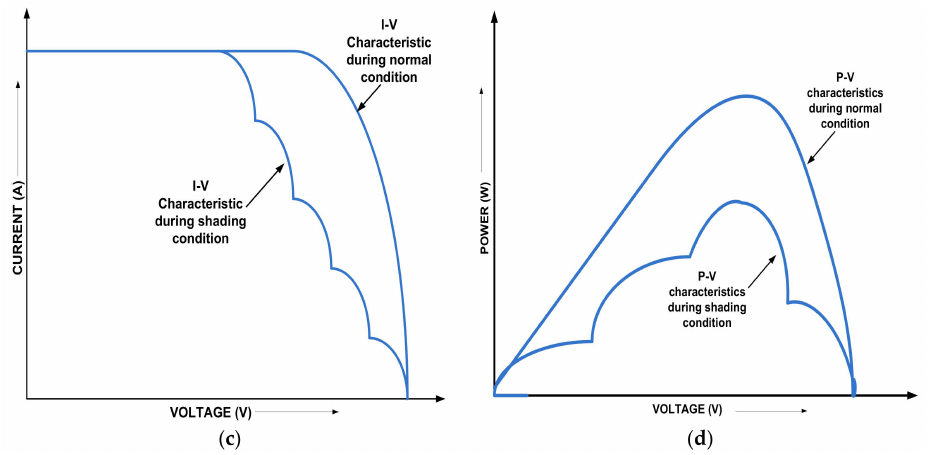
Figure 4. PV panels operation during partial shading conditions: ( a ) PV panels under normal operation, ( b ) PV panels under a shading condition, ( c ) I–V characteristic of PGS during partial shading, and ( d ) P–V characteristic of PGS during partial